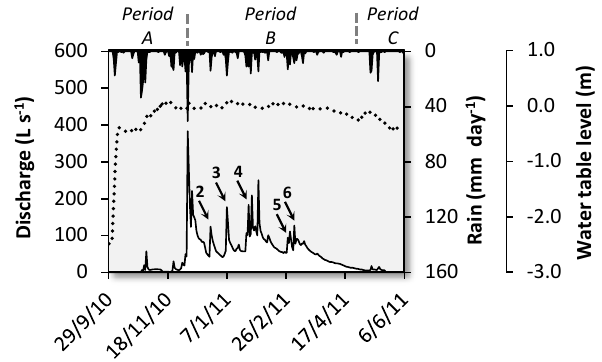
Figure 2. Discharge (white area), daily rainfall (black area) and wa- ter table level in the wetland domain (dashed line) during the hy- drologic year 2010–2011. Sampled storm events are indicated by numbers and arrows. Dates are given in